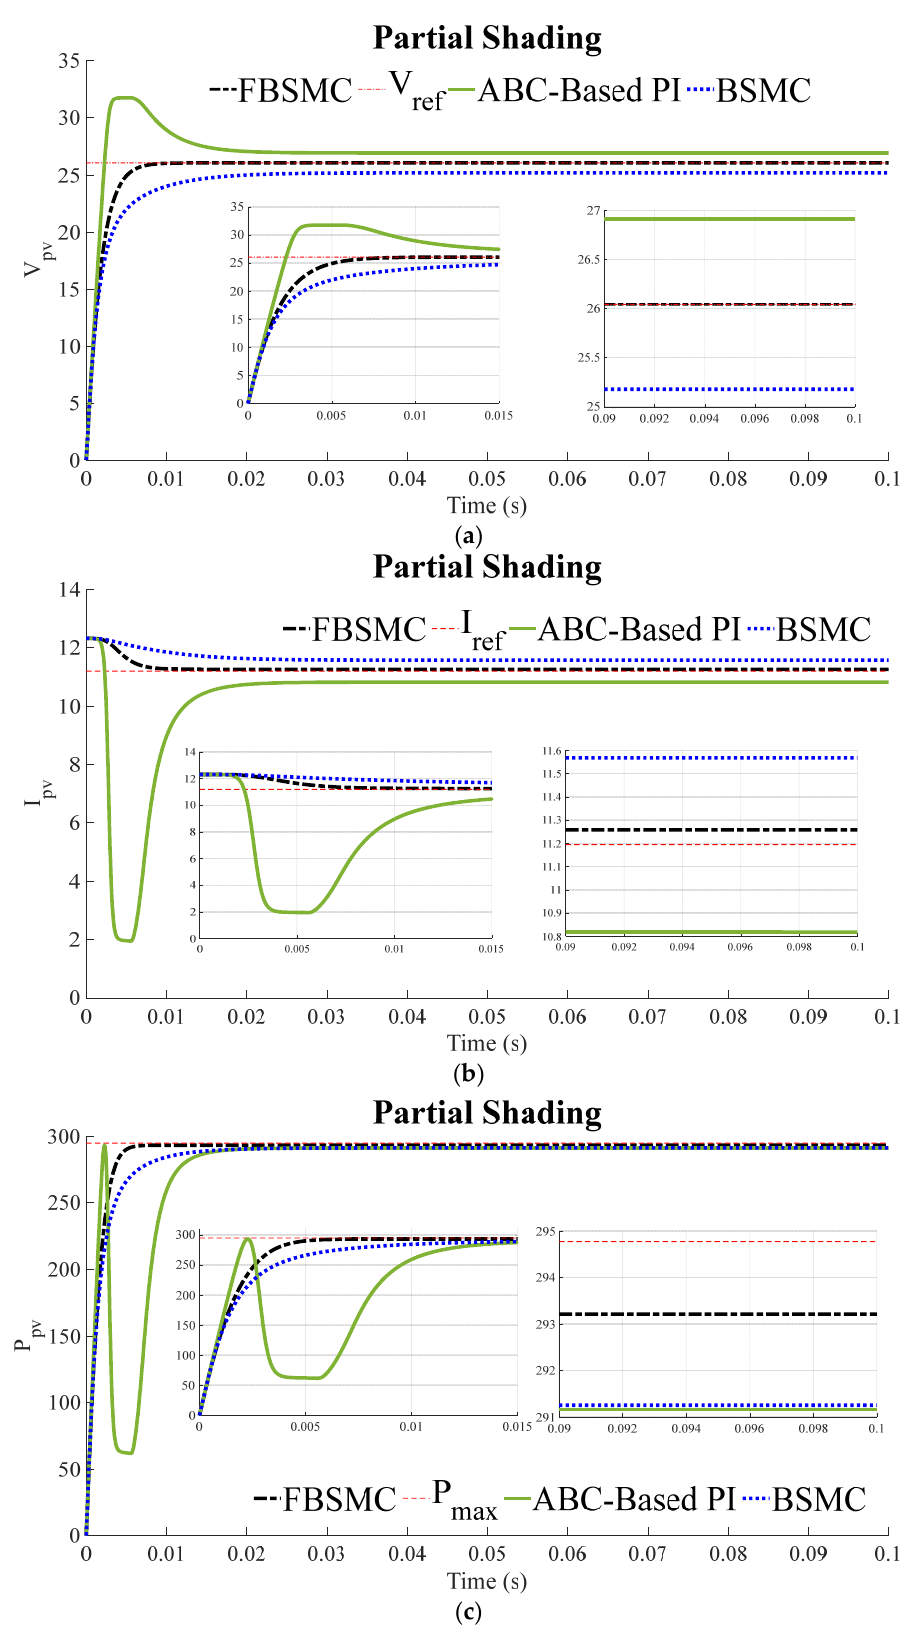
Figure 7. ( a ) Voltage ( b ) current, ( c ) power of the controlled PV (Scenario 4).